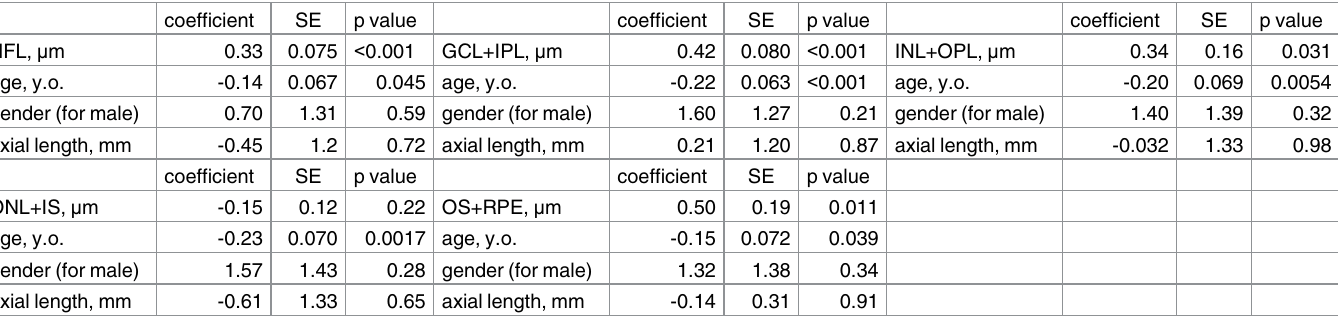
Table 2. The relationship between retinal layer thickness measurements and mTH (each thickness was analyzed in a separatelinear model). coefficient SE p value coefficient